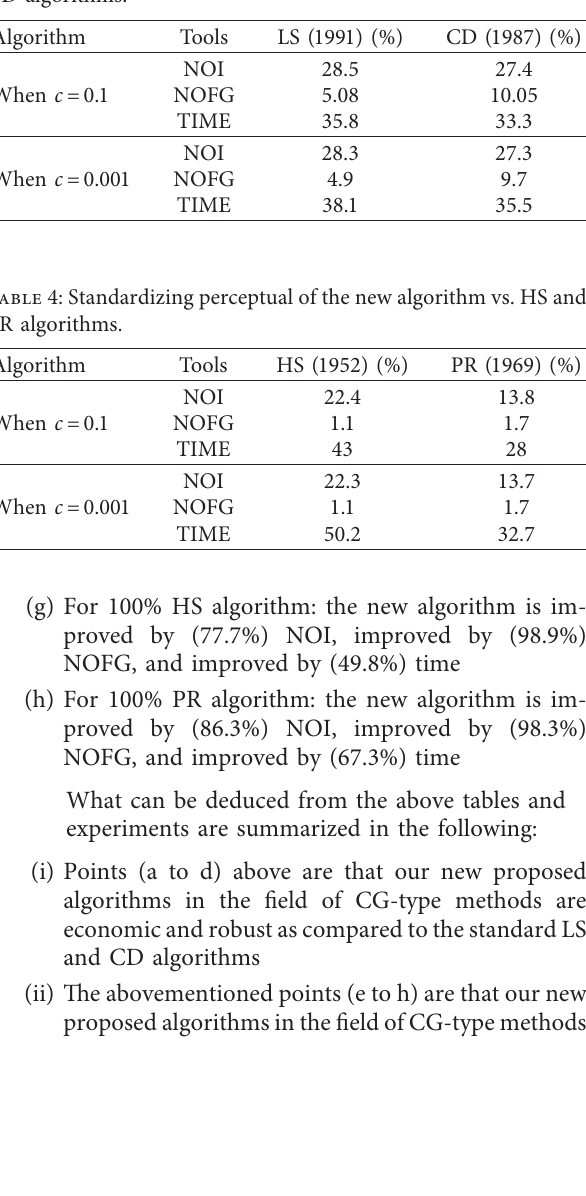
Table 3: Standardizing perceptual of the new algorithm vs. LS and CD algorithms.